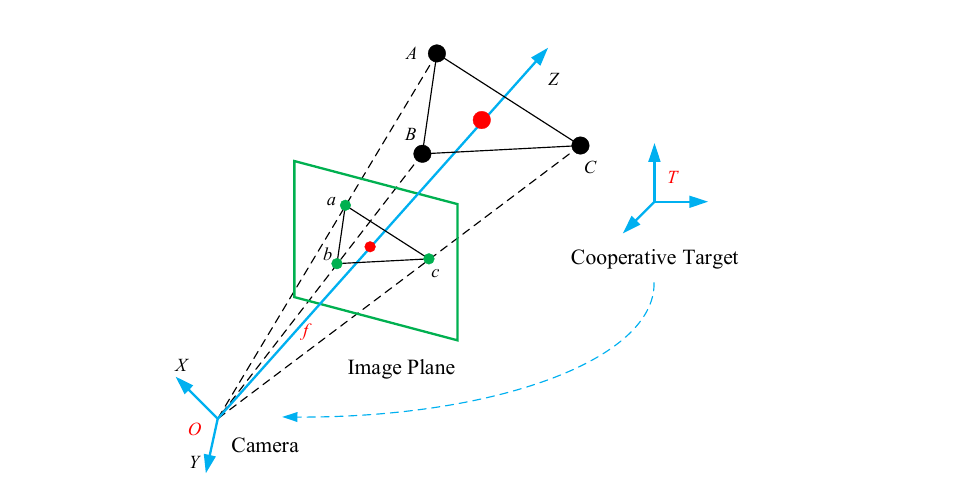
Figure 1. Sketch map of monocular vision measurement system with three feature points.